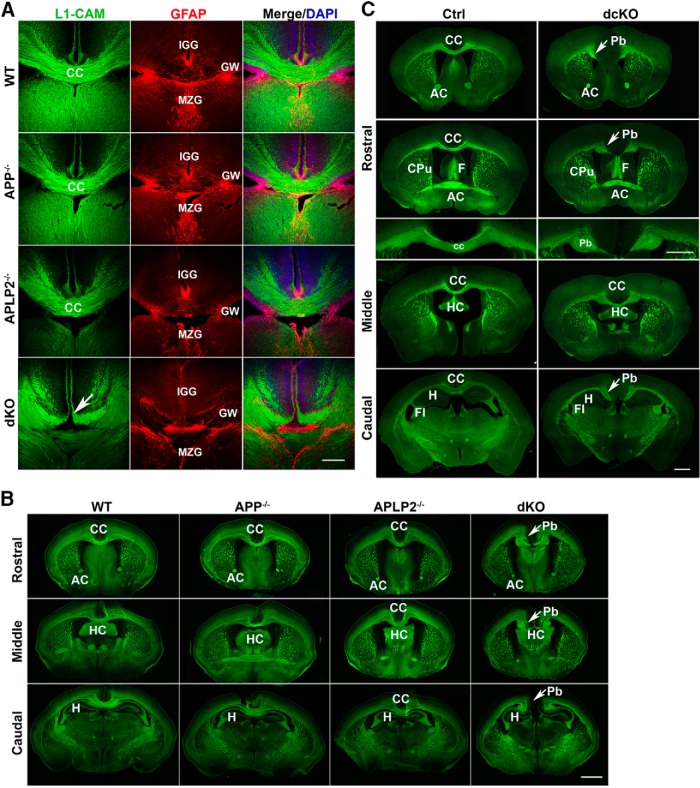
Abnormal development of the CC in APP/APLP2 double mutant mice. A, Presence of midline glial structures but severe cortical callosal projection deficits in APP/APLP2 dKO mice. Coronal brain sections of P0 littermates of WT, APP−/−, APLP2−/−, and APP/APLP2 dKO mice were colabeled with L1-CAM and GFAP, the latter identifies all three midline glial populations. GW: glial wedge; IGG: indusium griseum glia; MZG, midline zipper glia. Arrow indicates failed midline crossing of CC in dKO mice. B, Neurofilament staining of P0 rostral, middle, and caudal coronal sections of WT, APP−/−, APLP2−/−, and dKO mice, showing similar CC structures in WT, APP−/−, and APLP2−/− mice but failed midline crossing and formation of Pbs in dKO mice. C, FluoroMyelin Green staining of serial rostral to caudal sections of adult mouse brains of control (Ctrl) and APP/APLP2 double conditional (dcKO) mice demonstrating dysgenesis of CC and appearance of ectopic Pb (arrows) in dcKO mice. CC: corpus callosum; AC: anterior commissure; HC: hippocampal commissure; CPu, caudate putamen; F, fornix; Fi, fimbria; H, hippocampus. Scale bars, 100 μm (A) and 1 mm (B, C).